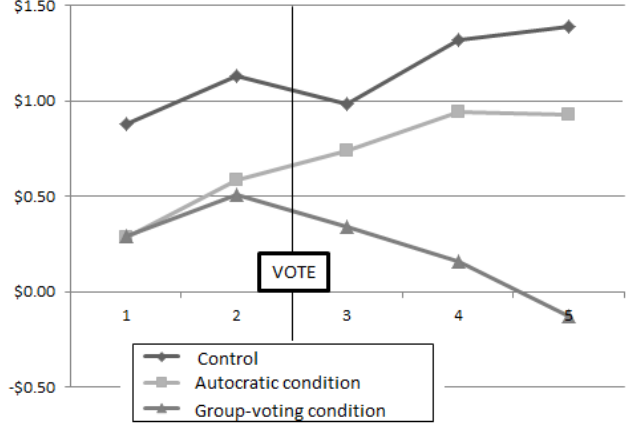
Figure 5. Difference in individual production between non-loafers and cyberloafers across periods and